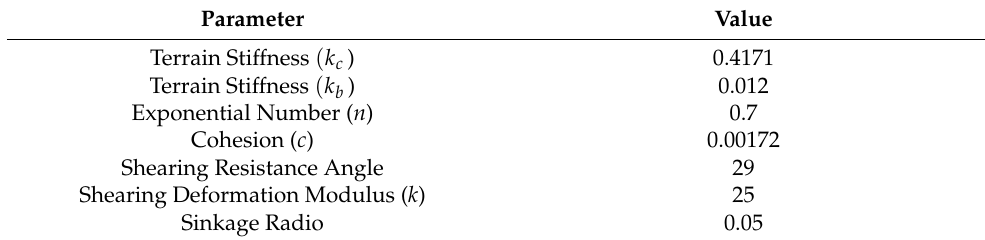
Table 1. Sediment parameters of the simulation model of DSLV.